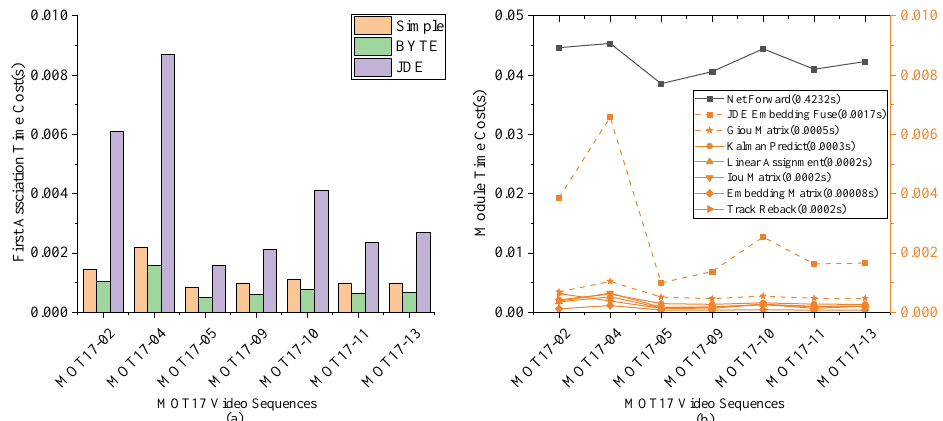
Figure 8. Comparison of different tracking algorithm speeds. ( a ) shows the tracking speed of different tracking algorithms. ( b ) shows the time consumption of several main modules in the tracking